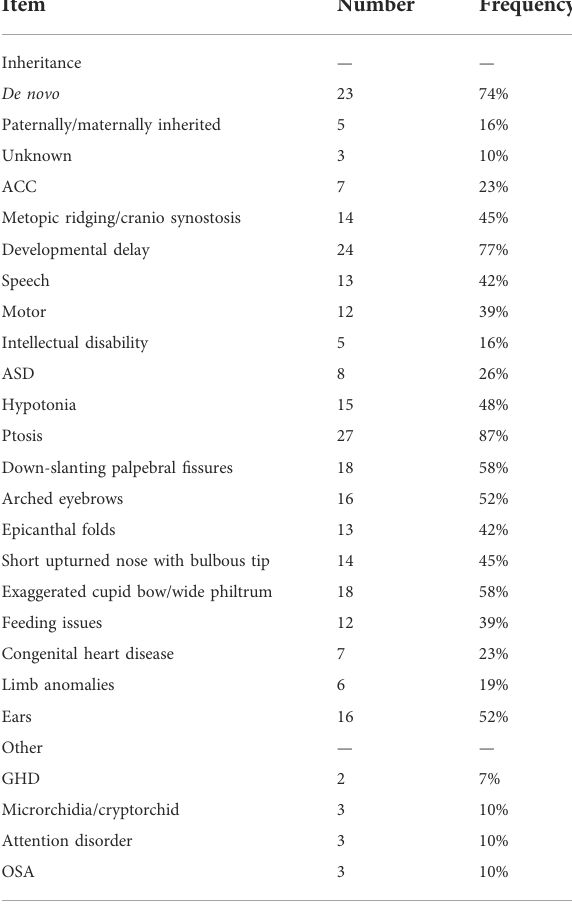
TABLE 2 Common clinical manifestations and frequency of WSKA